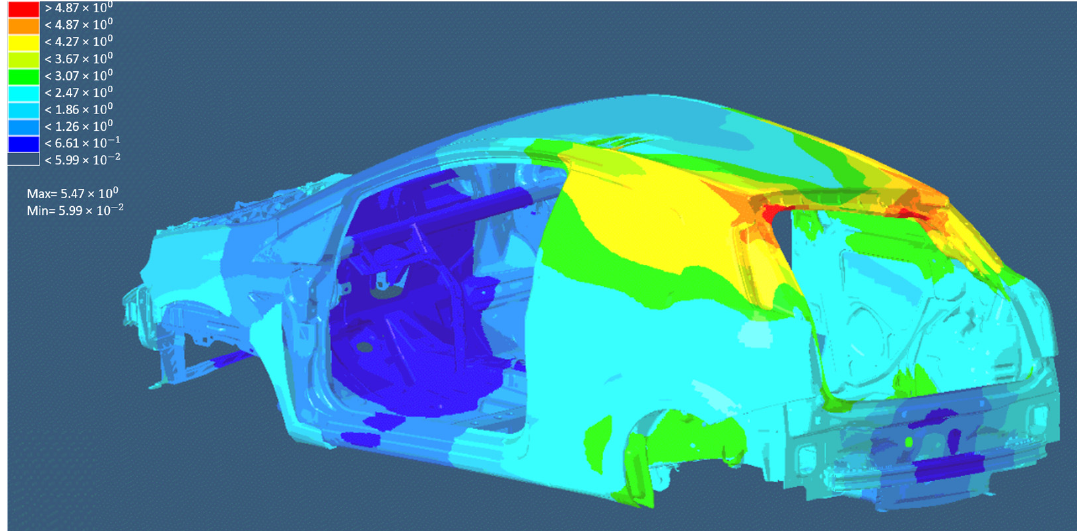
Figure 3. First torsional mode on BIW model.